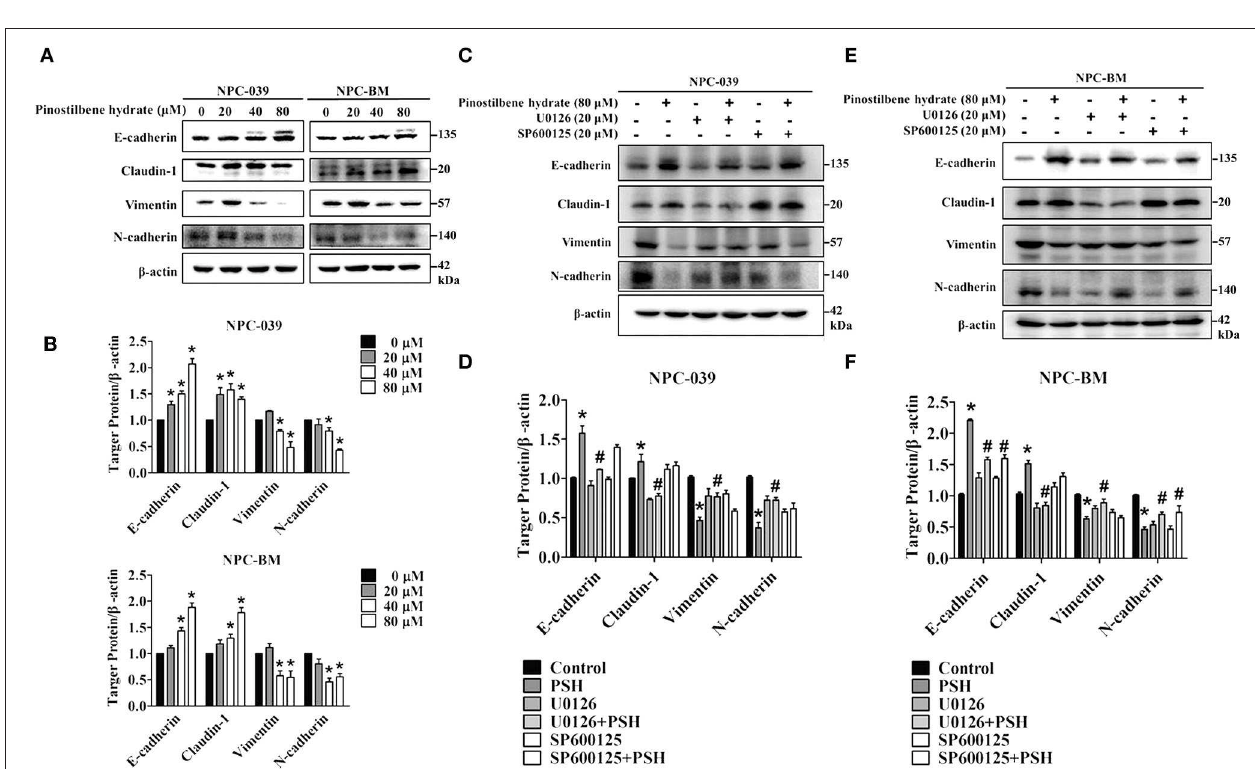
FIGURE 5 | PSH suppressed EMT on NPC cells via the MAPK signaling pathways. (A,B) Cells were treated with PSH (0–80 µ M) for 24h. The expression levels of epithelial marker proteins (E-cadherin, Claudin-1) and mesenchymal marker proteins (vimentin, N-cadherin) were analyzed by Western blot. PSH upregulated the expression of E-cadherin and Claudin-1 while downregulating that of N-cadherin and vimentin on both NPC cell lines. * P < 0.05, compared with the control (0 µ M). (C,D) Combined treatment of PSH with U0126 in NPC-039 cells showed significant increased levels of vimentin and N-cadherin with decreased levels of E-cadherin and Claudin-1 when compared with 80 µ M PSH treatment only group. * P < 0.05, compared with the control. # P < 0.05, compared with 80 µ M PSH treated only group. (E,F) Relative to the group treated with 80 µ M PSH alone, a co-treatment of PSH with U0126 or SP600125 in NPC-BM cell lines elevated the expression levels of mesenchymal markers and suppressed the expression of epithelial marker proteins. * P < 0.05, compared with the control. # P < 0.05, compared with 80 µ M PSH treated